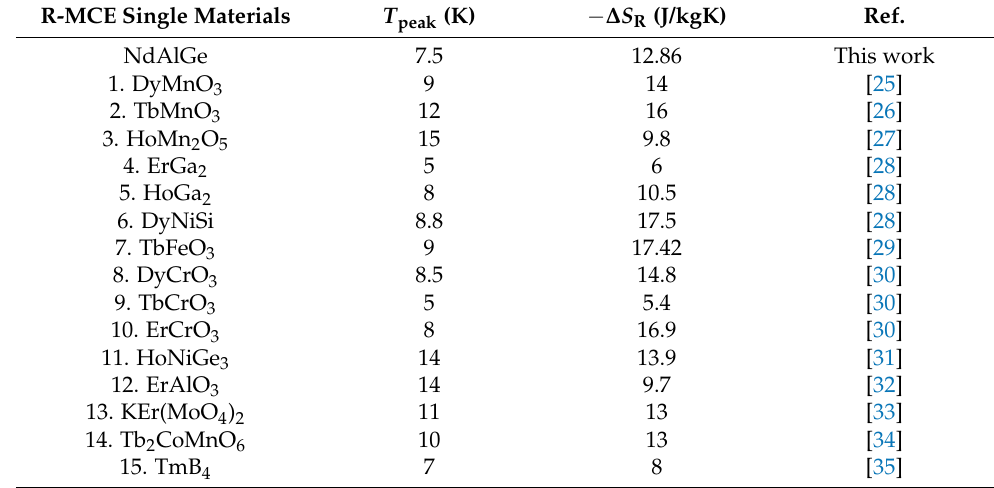
Table 2. R-MCE of single materials in Figure